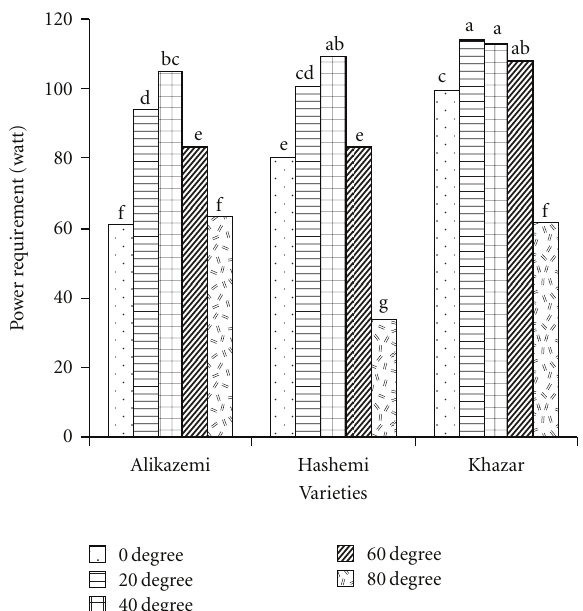
Figure 2: Mean comparison results of interaction e ff ects of variety and inclination angle on power requirement (dissimilar letters show di ff erent significantly at probability level %5).